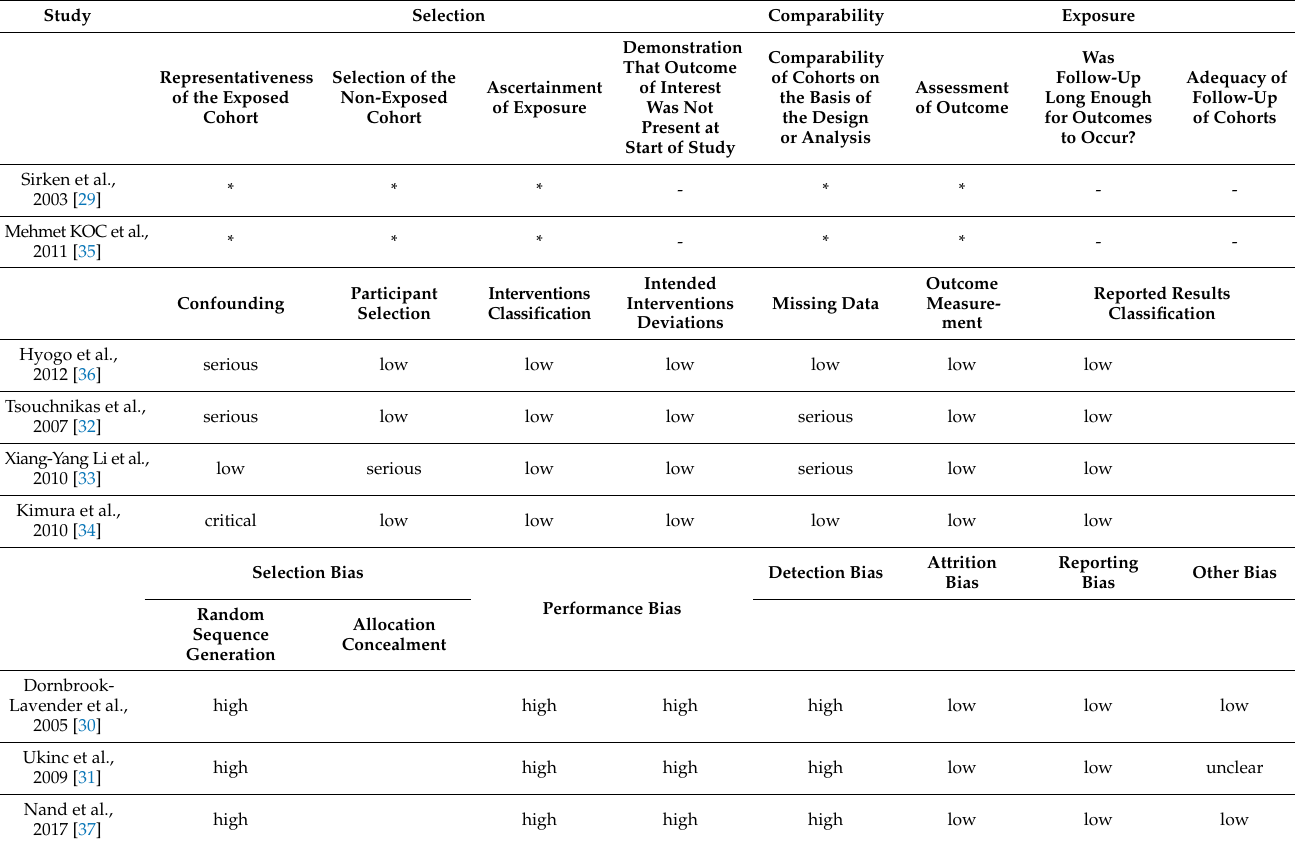
Table 2. Quality of bias assessment of the included